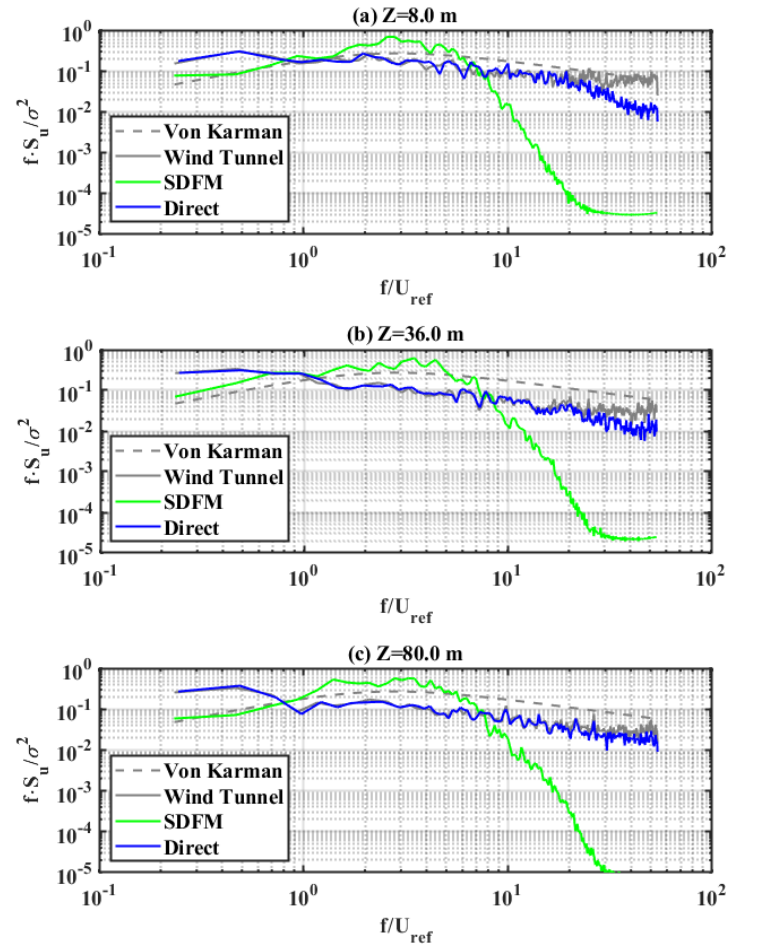
Figure 8. Spectrum of longitudinal velocity from von Karman, experiments, SDFM, and direct methods for ( a ) 8.0 m, ( b ) 36.0 m, and ( c ) 80.0 m height at